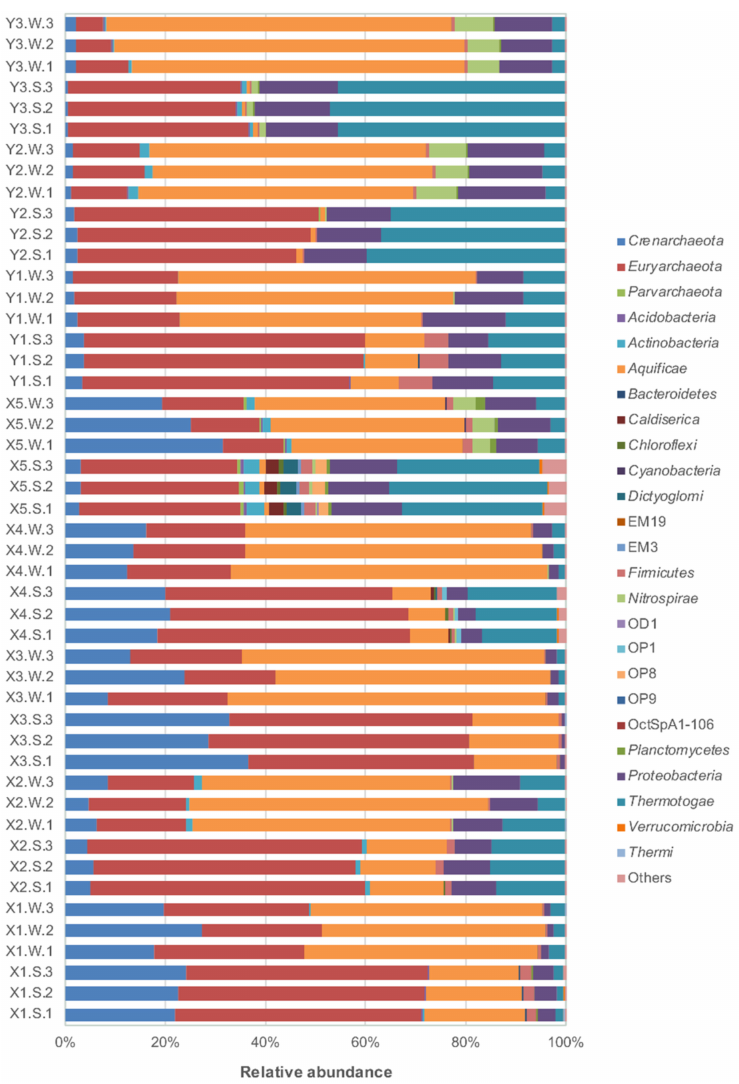
Figure 4. Relative abundances of microbes in all 48 samples at the phylum level. For stream X, five sampling points, except confluence site X5, the compositions of bacteria and archaea between the water and sediment samples were quite different (Figure 4). In addition, the top three highest relative abundances of bacterial phyla in the water samples were Aquificae (34.06–63.48%), Proteobacteria (1.06–13.66%) and Thermotogae (1.33–12.71%). The sediment groups with the highest relative abundances also